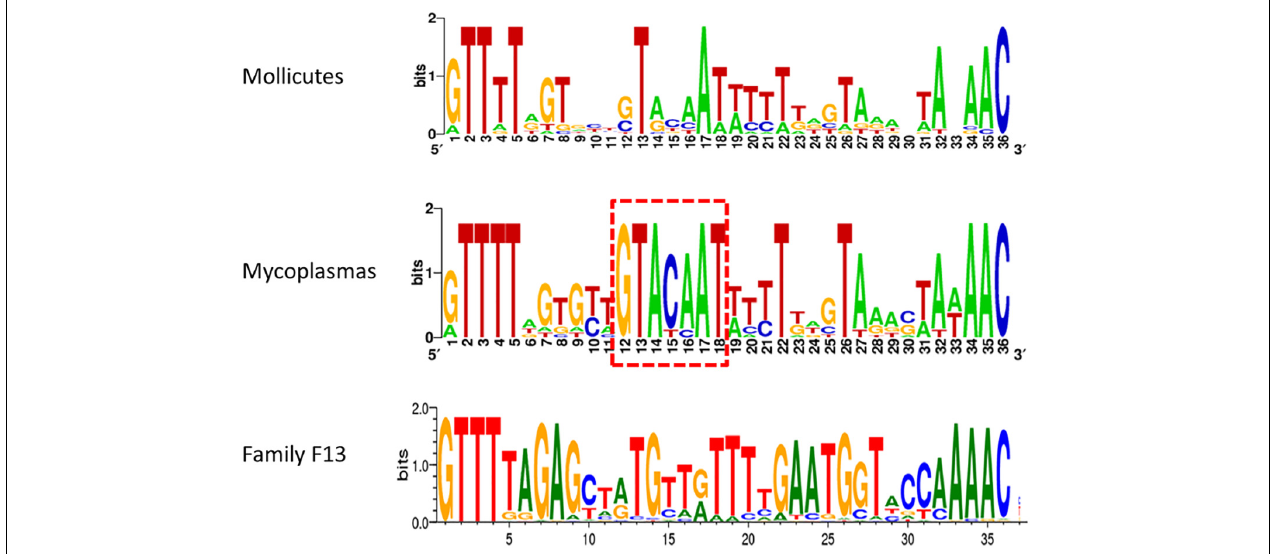
FIGURE 3 | Consensus sequence of Direct Repeats of mollicutes and mycoplasmas CRISPR. DR sequences from 17 CRISPR systems of mollicutes were used to create a weblogo at http://weblogo.berkeley.edu/. These logos were somewhat similar to the one from Family F13 of DR defined in CRISPRMap. The internal motif conserved at positions 12–18 in most mycoplasmas is framed in red